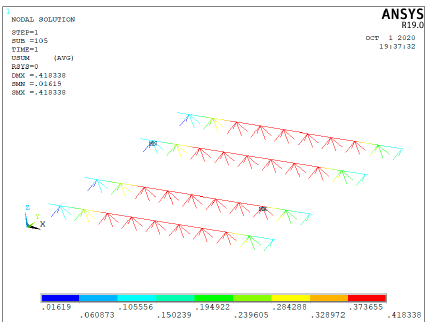
Figure 35. Deformation cloud diagram of truss rib under ultimate load.